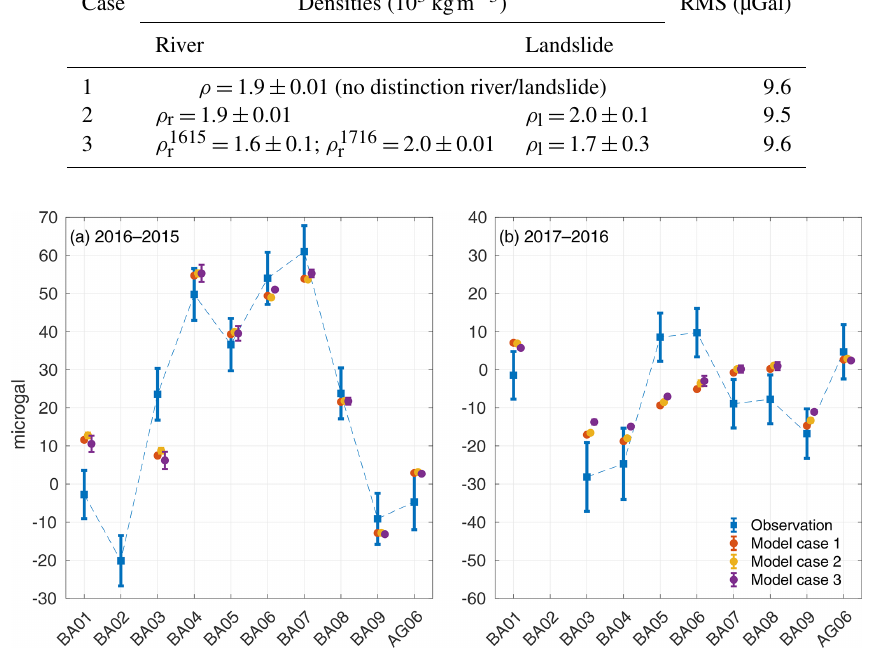
Figure 9. Comparison of the observed (blue) and modeled gravity changes for the densities inverted in cases 1, 2 and 3 (red, yellow and purple, respectively). Each case is slightly offset horizontally for legibility. No gravity is estimated at BA02 since its location is